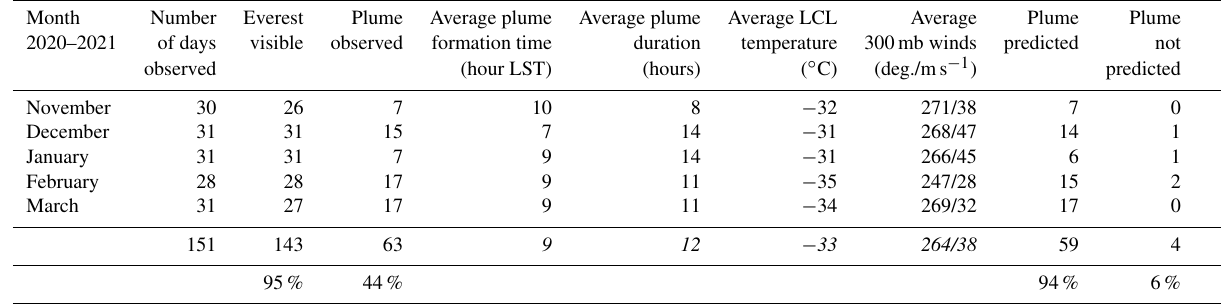
Table 2. Results from the observations of Himawari-8 imagery and the lifted condensation level (LCL) calculations from the corresponding atmospheric profiles (roman text denotes summed values, italics denotes average